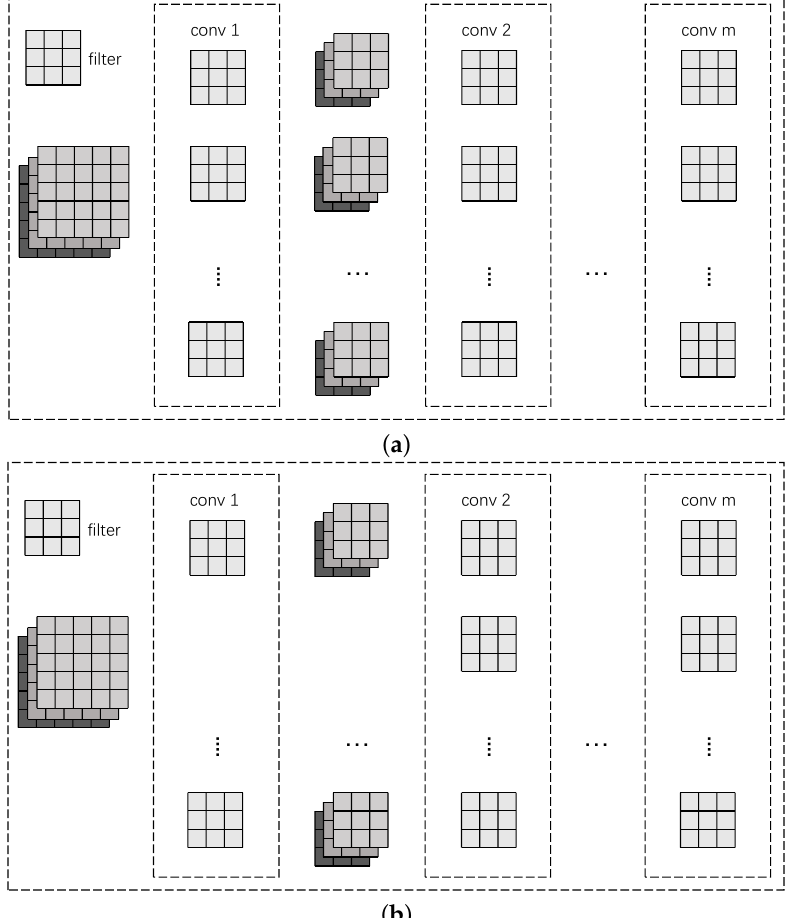
Figure 2. Randomly disconnect the 10% filter of conv1. ( a ) Network structure before disconnecting the 10% filter. ( b ) Network structure after disconnecting the 10%